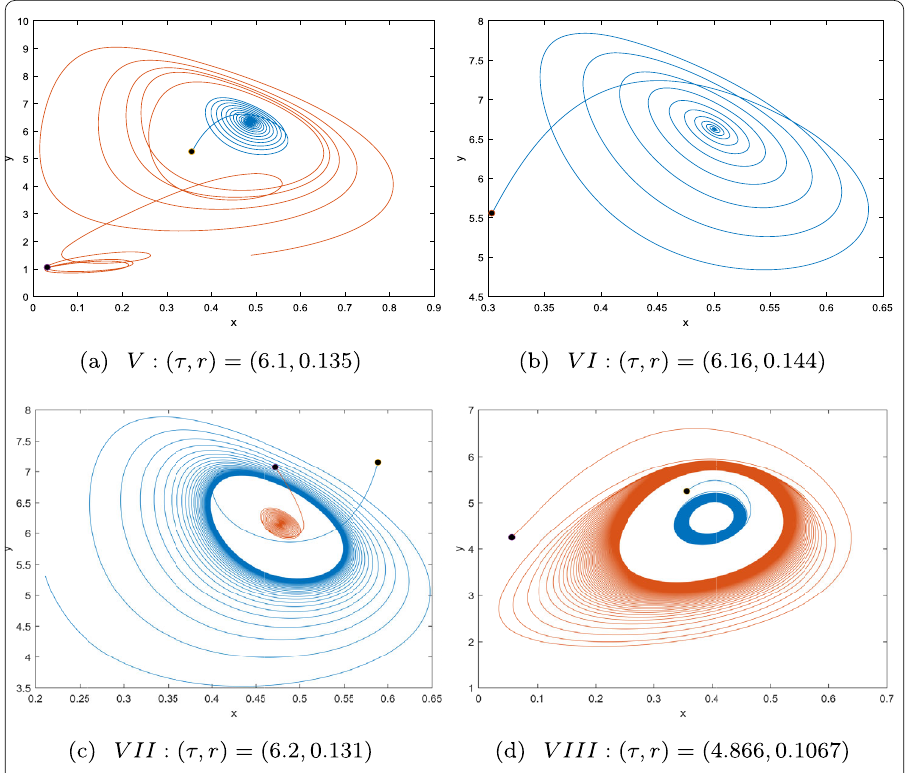
Figure 4 Trajectories of system (1) with different parameters and initializations in regions ( V – VIII ) of Fig. 1. (a)An asymptotically stable solution with the initial value (0.256326,2.74507) and an unstable periodic solution with the initial value (0.032247,1.0489). (b)An asymptotically stable solution with the initial value (0.30326,5.5545). (c)Similarly to (a), an asymptotically stable solution with the initial value